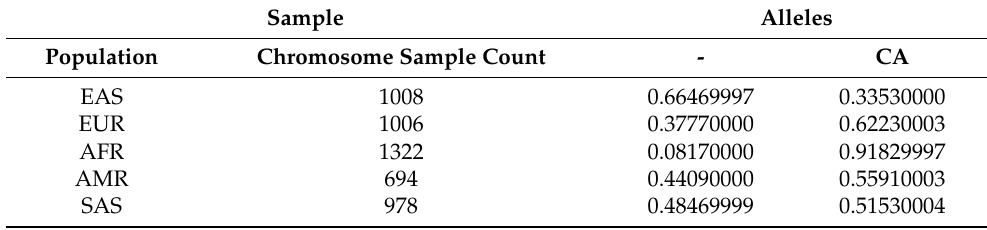
Table 1. Allelic frequency of 2bp deletion ( -/TG ) from the 1000 Genomes Project. EAS = East Asian; EUR = European; AFR = African; AMR = Ad-mixed Americans; SAS = South Asian. Sample